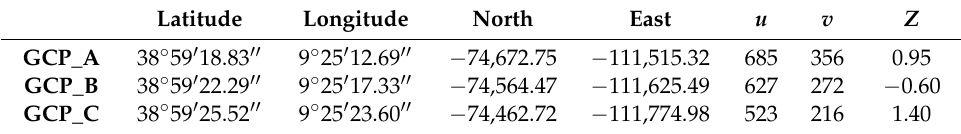
Figure 5. Computational example of GCPs’ elevation. The 32 detected shorelines are plotted with crosses, surveyed points intercepted by shorelines with dots, Google Earth-derived GCPs with squares. Inset shows the tidal variation measured by TG. White triangle shows deployed PT location. Shorelines colors correspond to tidal elevation, while surveyed GCPs colors refer to field-survey elevation. Table 1. Remotely-retrieved GCPs location. Latitude and longitude refer to Google Earth map coordinates (WGS84), North and East to coordinates transformed to local system (ETRS89—Portugal TM06). Coordinates u , v are pixel coordinates in the oblique surfcam image. Z refers to GCPs elevation estimated from shoreline position and elevation. For the GCPs names and numbers, refer to Figures 4 and 5.